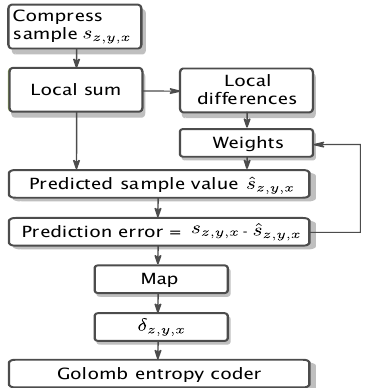
Figure 3. Flowchart of the CCSDS 123 algorithm.